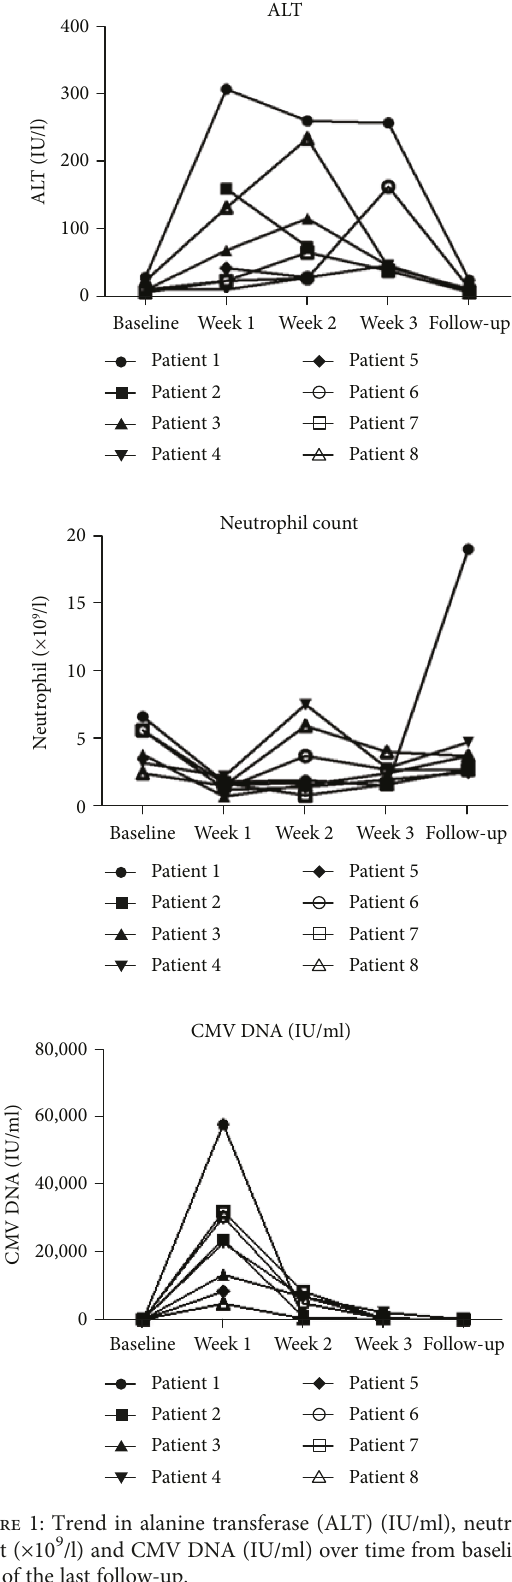
Figure 1: Trend in alanine transferase (ALT) (IU/ml), neutrophil count ( × 10 9 /l) and CMV DNA (IU/ml) over time from baseline to time of the last